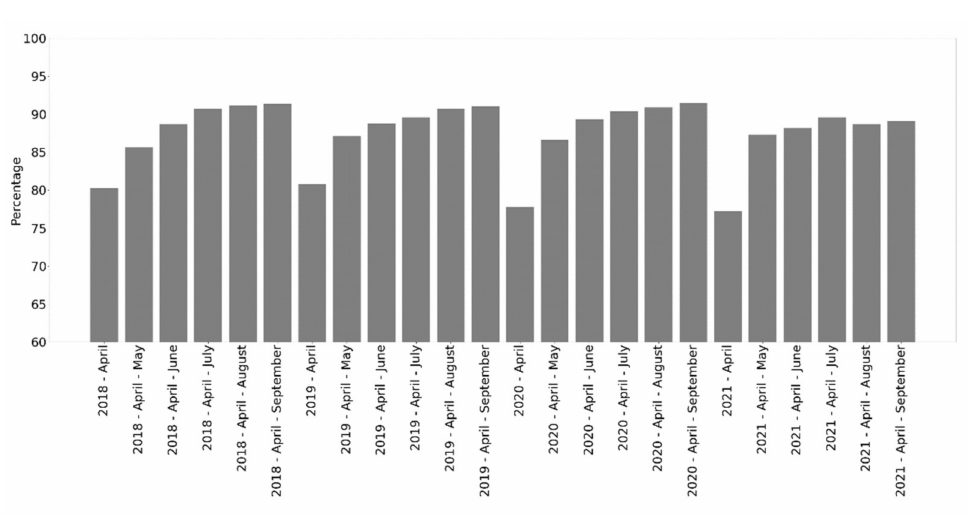
Figure 7. Overall accuracy of temporally aggregated monthly composites.